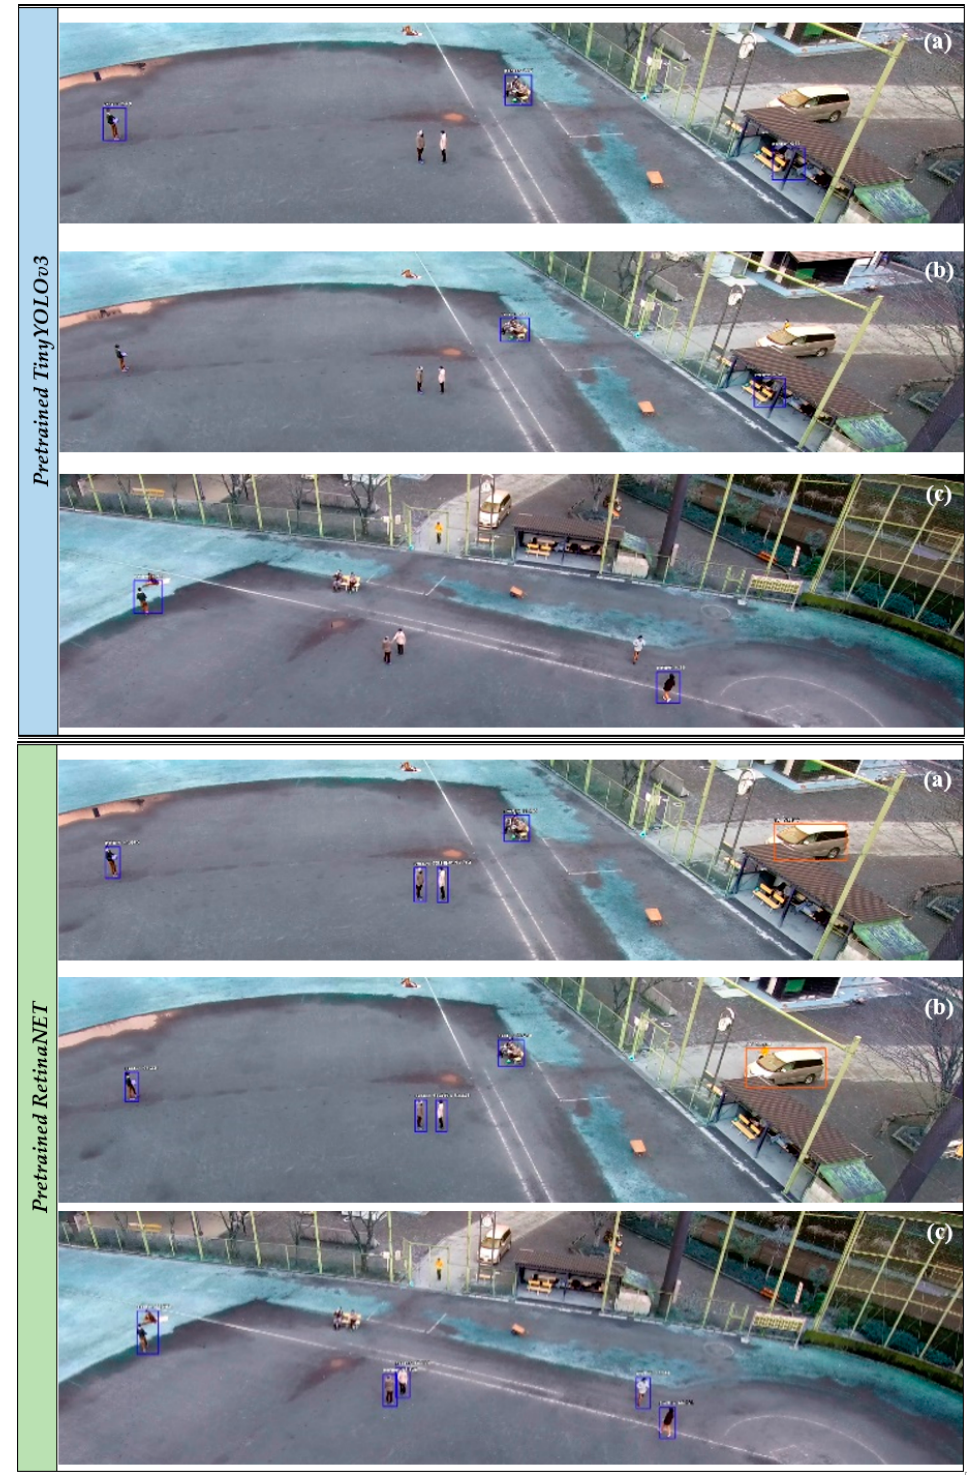
Figure 9. Object detection results (persons in blue rectangles and cars in orange rectangles) as the time goes on (frames ( a – c )) on the OKUTAMA dataset and applying several deep learning schemes.